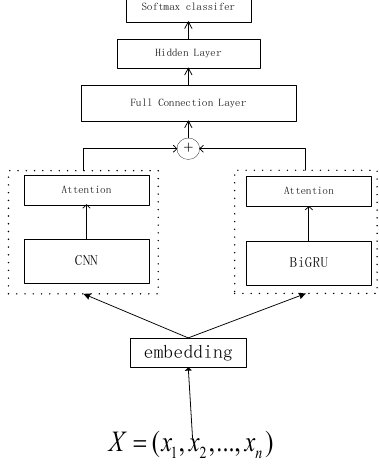
Fig. 1. Overall architecture diagram of the